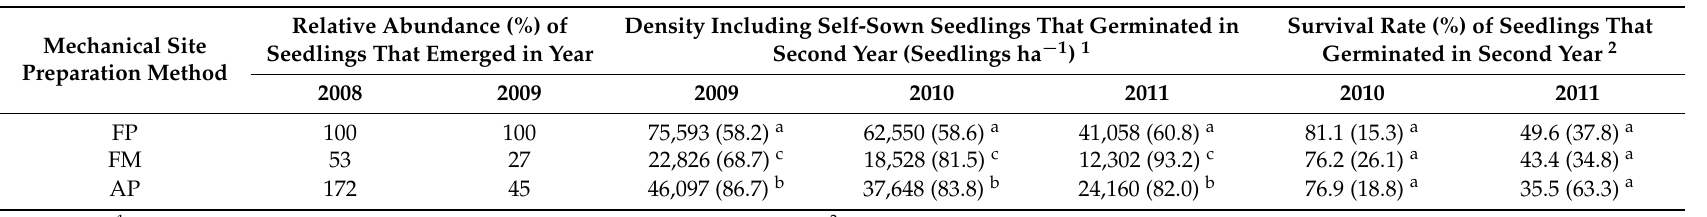
Table 3. Relative abundance of Scots pine seedlings that germinated in the first and second growing seasons, seedling density (including self-sown seedlings that germinated in the second year) and survival rate of self-sown seedlings that germinated in the second year (mean and coefficient of variation in brackets) in natural regeneration, depending on mechanical site preparation methods (forest plough (FP); forest mill (FM); active plough